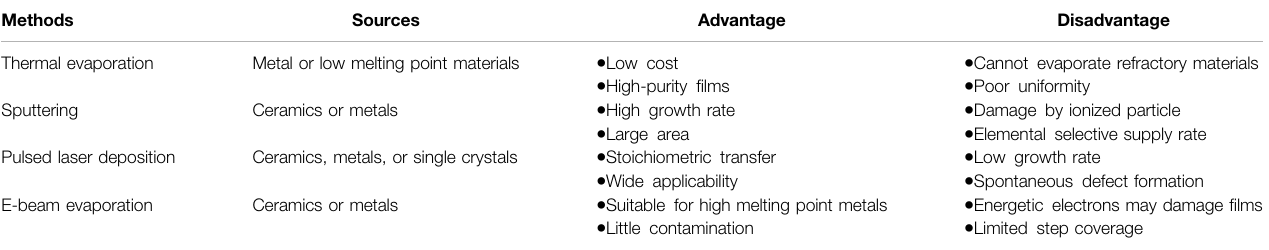
TABLE 1 | Summary of the advantages and disadvantages of PVD